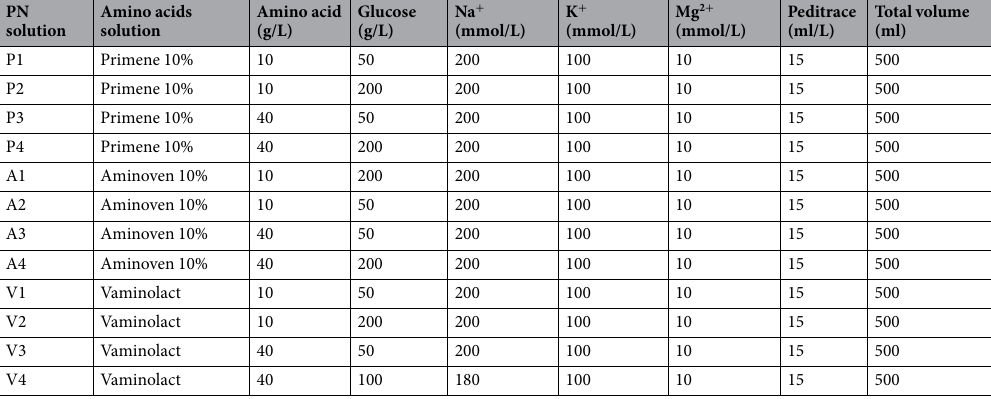
Table 4. Composition of PN Solutions under